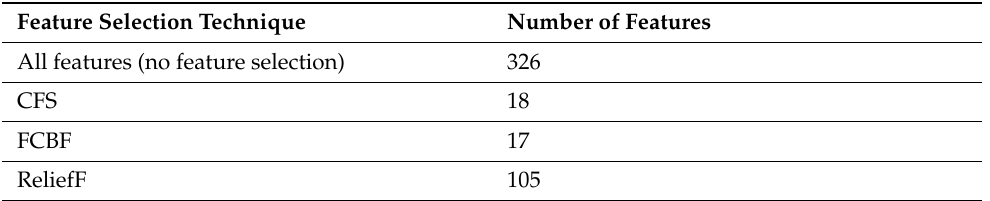
Table 6. Number of features used in the classical machine learning based PAC system.